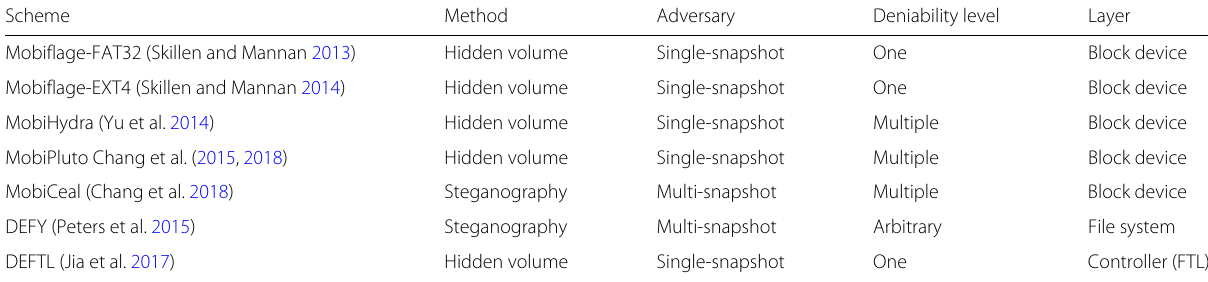
Table 2 Comparison of PDE systems for mobile devices